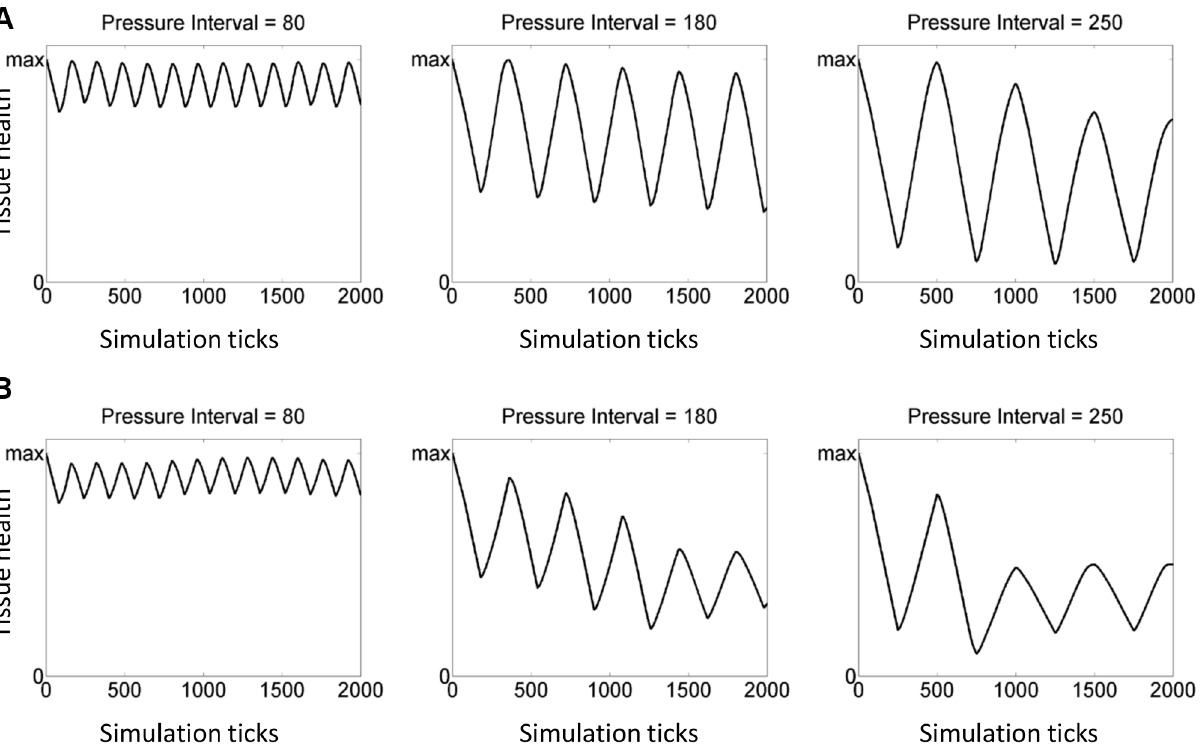
Figure 8. Simulation of different pressure scales on the health of epithelial cells. Graphs with different values of the pressure interval show how the predicted health of epithelial cells progresses over time for simulations of the control and SCI groups, respectively. Panel (A) shows the outcome of simulations for the control group. Panel (B) shows the outcome of simulations for the SCI group.